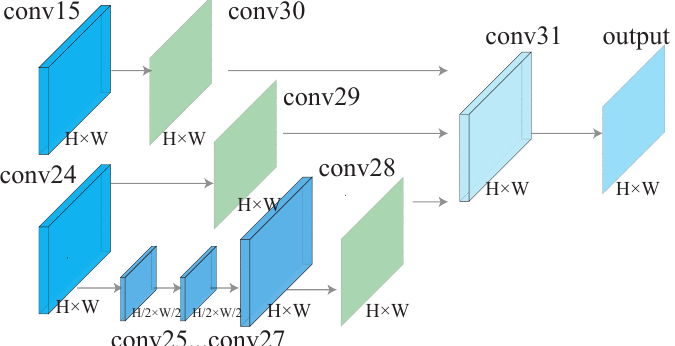
Figure 3. The decoder architecture. The input of the decoder is conv15 and conv24, which are learnt by the encoder. The decoder consists of three branches, and the output of three branches are further concatenated to generate the output of the LightEyes. Moreover, there are three supervision losses after conv28, conv29, and